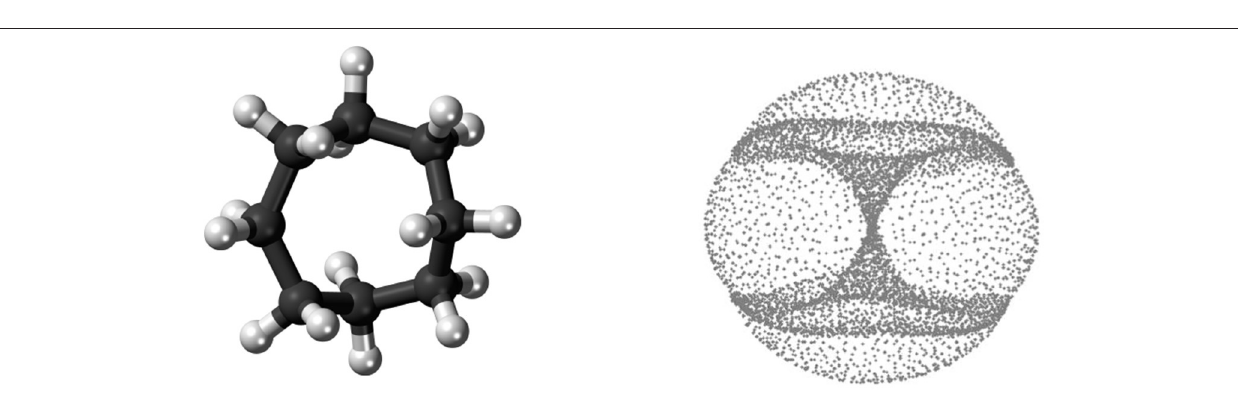
FIGURE 4 | (Left) The cyclo-octane molecule consists of a ring of 8 carbon atoms (black), each bonded to a pair of hydrogen atoms (white). (Right) A PCA projection of a dataset of different conformations of the cyclo-octane molecule; this shape is a sphere glued to a Klein bottle (the “hourglass”) along two circles of singularity. The right image is from Martin et al.